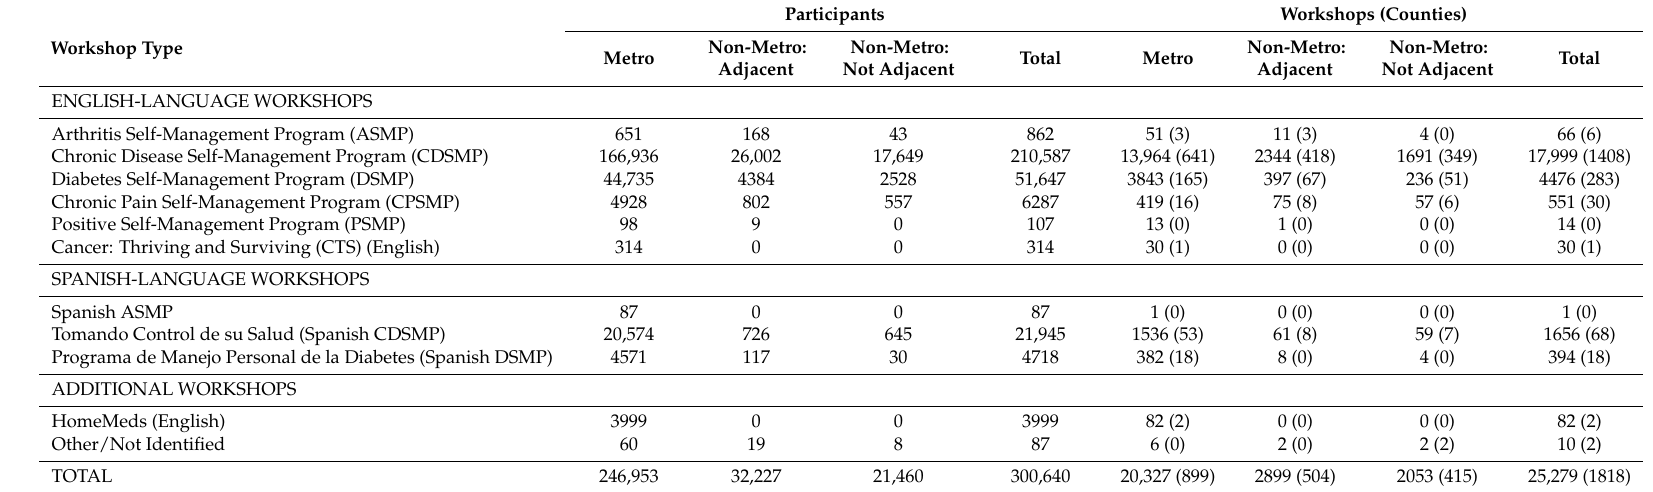
Table 1. CDSME Program workshop types by rurality.